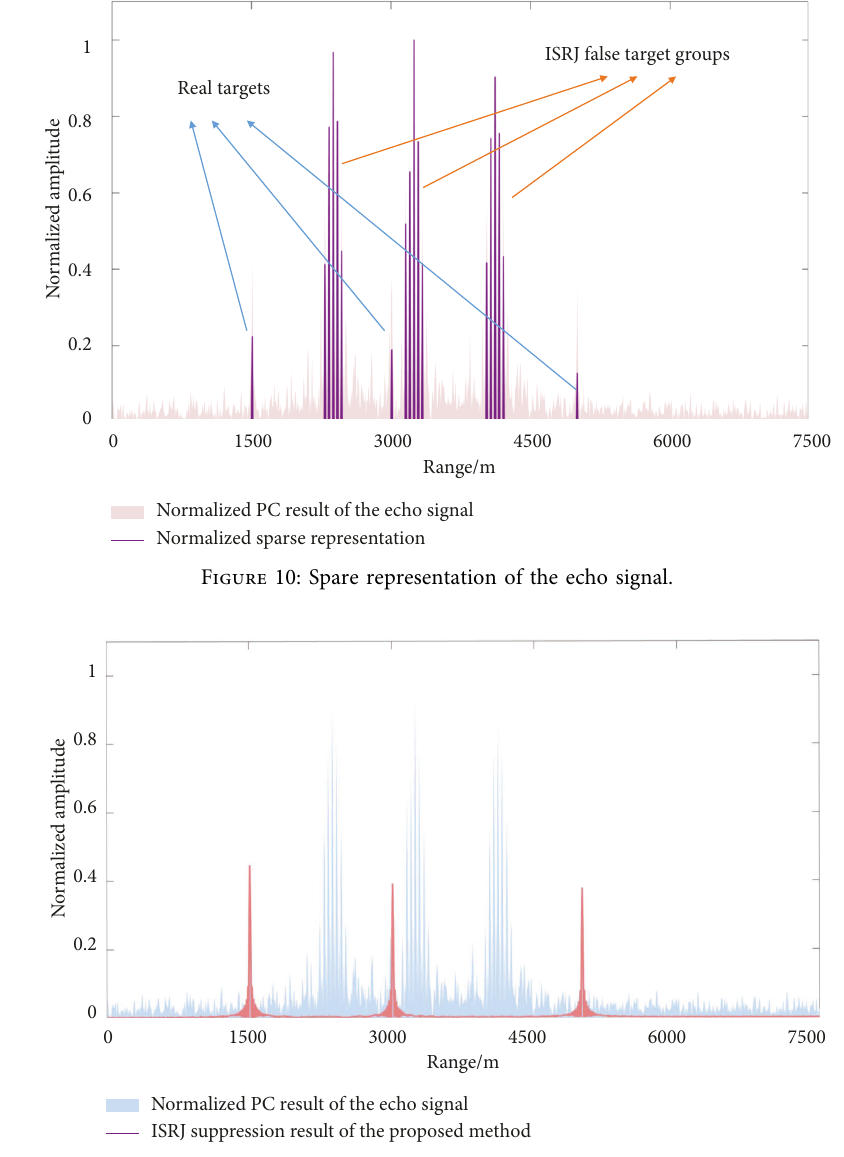
Figure 11: ISRJ suppression result of the proposed method.